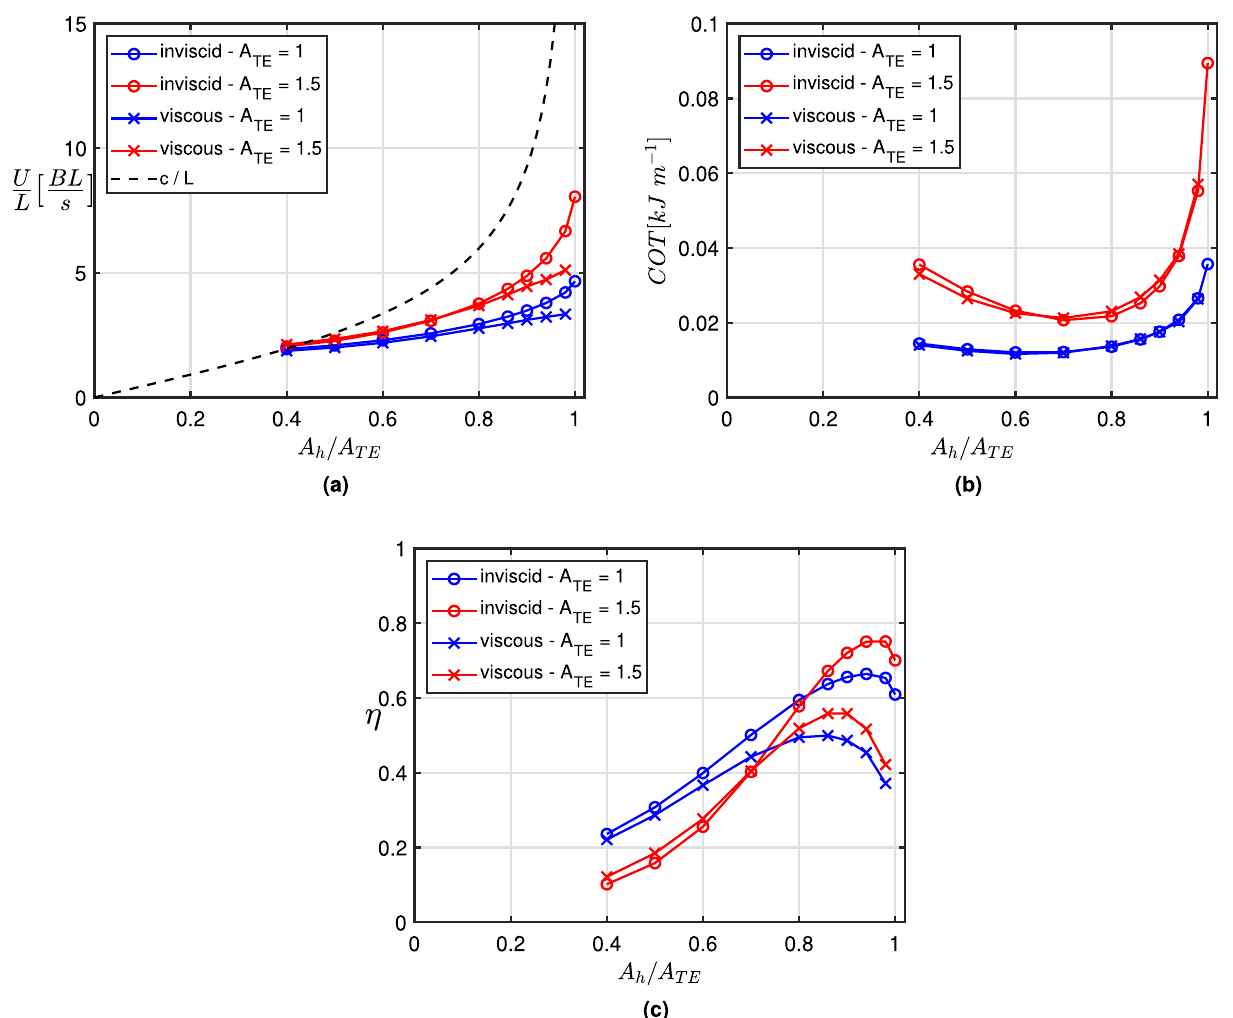
Figure 3. ( a ) Mean steady state swimming velocity U / L and phase velocity c / L (dashed line), ( b ) cost of transport of the whole body and ( c ) efficiency of the propulsor against A h ∕ A TE for different peak-to-peak trailing edge oscillation amplitudes ( A TE = 1 and 1.5). Viscous and inviscid numerical solutions for a prescribed virtual body resistance.